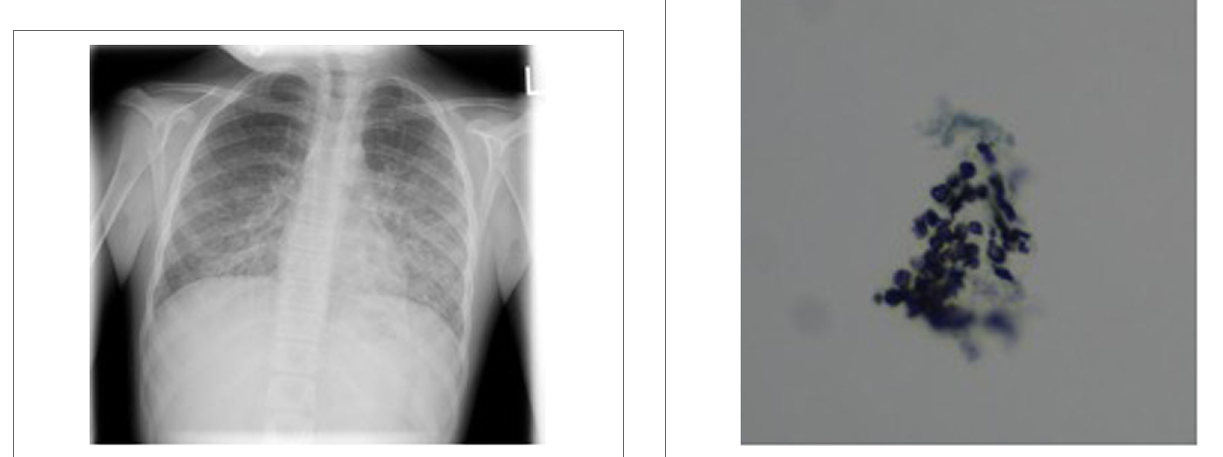
FIgURe 2 | Grocott–Gomori’s methenamine silver stain of sputum specimen showing “cup shaped” Pneumocystis jirovecii cysts in small aggregates.